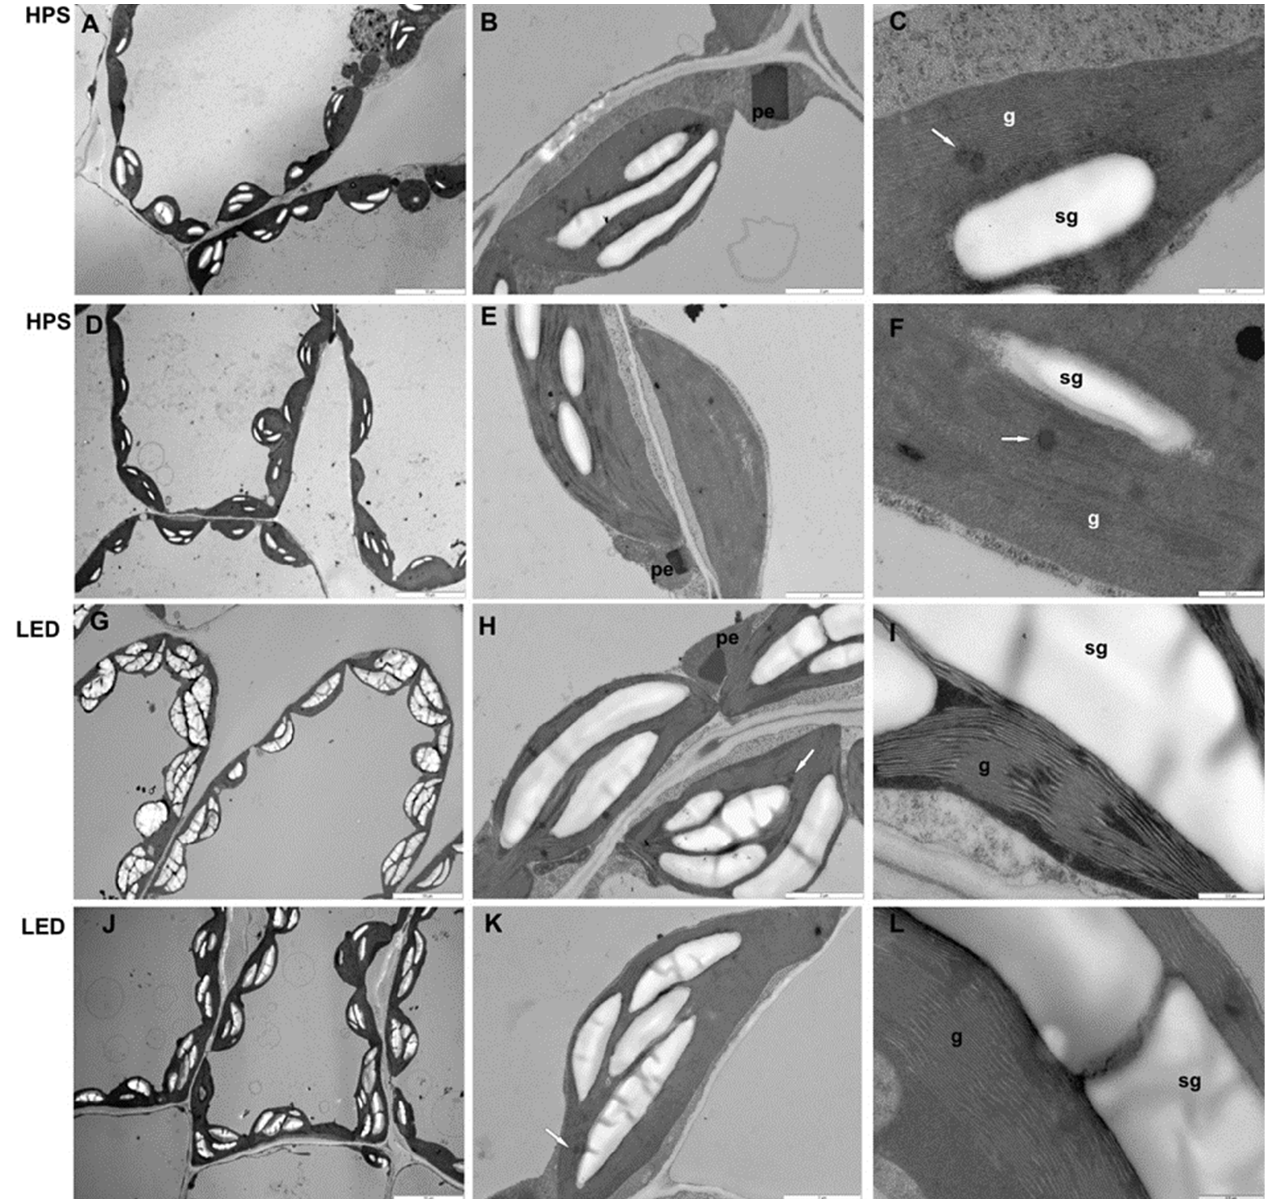
Figure 5. The effects of different lighting systems on the mesophyll parenchyma and chloroplast ultrastructures in pepper leaves (cv. ‘Aifos’ or ‘Palermo’): ( A – C ) ‘Aifos’ HPS; ( D – F ) ‘Palermo’ HPS; ( G – I ) ‘Aifos’ LED; ( J – L ) ‘Palermo’ LED. Abbreviations: pe—peroxisome; white arrow—plastoglobule; sg—starch granule; g—granum; HPS—sodium lamp; LED—light-emitting lamp. ( A , B , D , E , G , H , J , K ) Scale bar—2 µm. ( C , F , I , L ) Scale bar—0.5 µm.